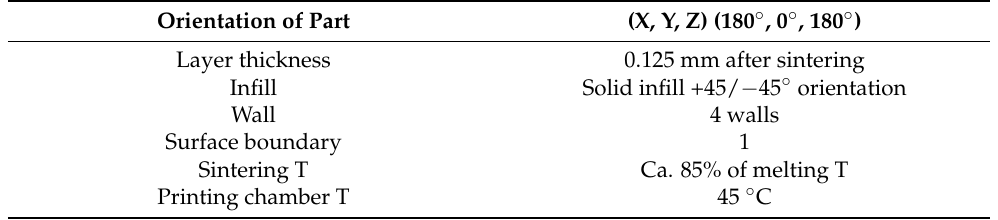
Figure 2. Orientation of filaments in the successive layers of parts. Table 2. Printing